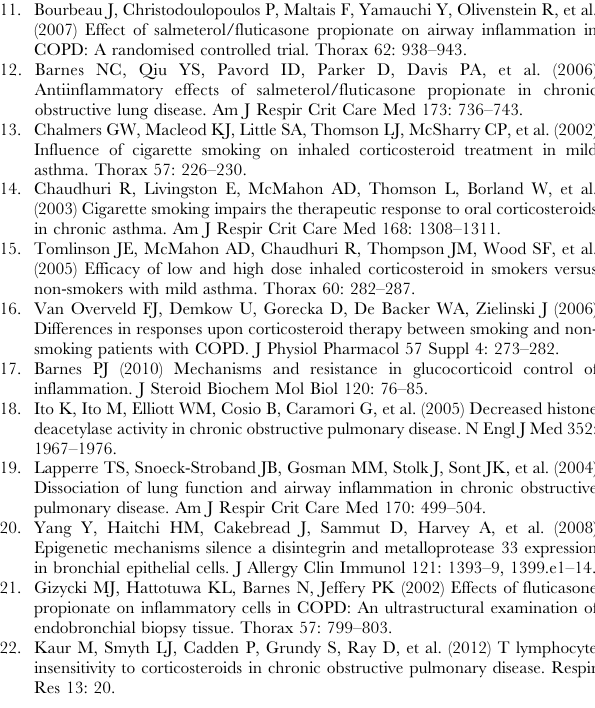
Table S1 Patients were selected from the GLUCOLD cohort [ 7 ] ; only persistent smokers and ex-smokers were included. All analyses are adjusted for age and sex. Data are expressed as B, p (regression coefficient, p-value); significant salbutamol expressed in liters; PC 20 =provocative concentration